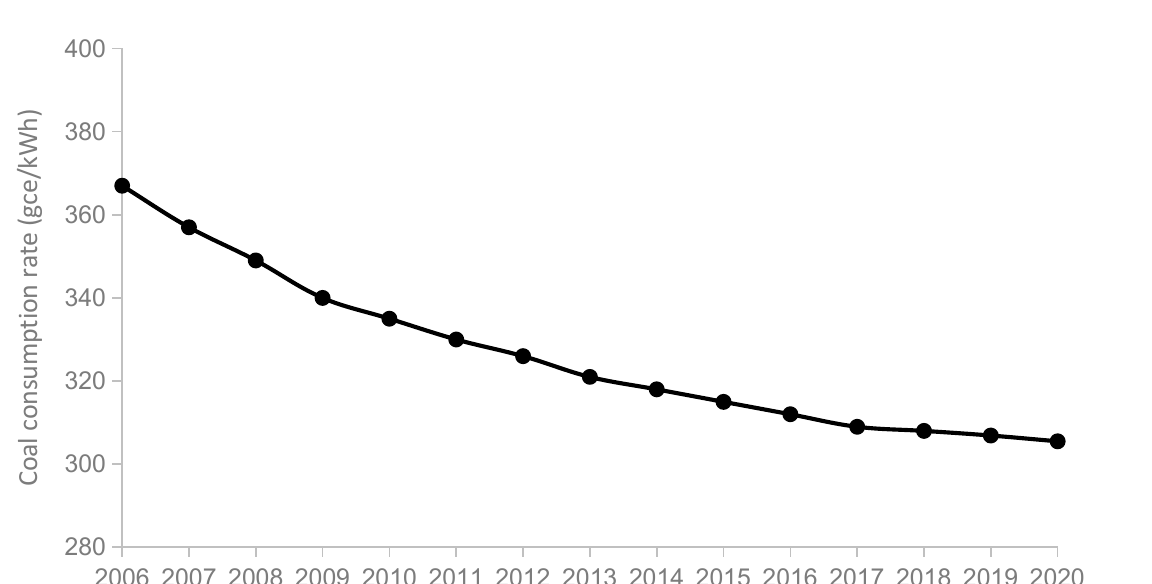
Figure 8. Average coal consumption rate of coal-fired power generation units.